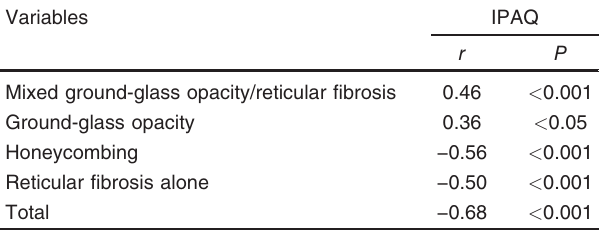
Table 7 Correlation between diffusion lung capacity for carbon monoxide and Saint George Respiratory